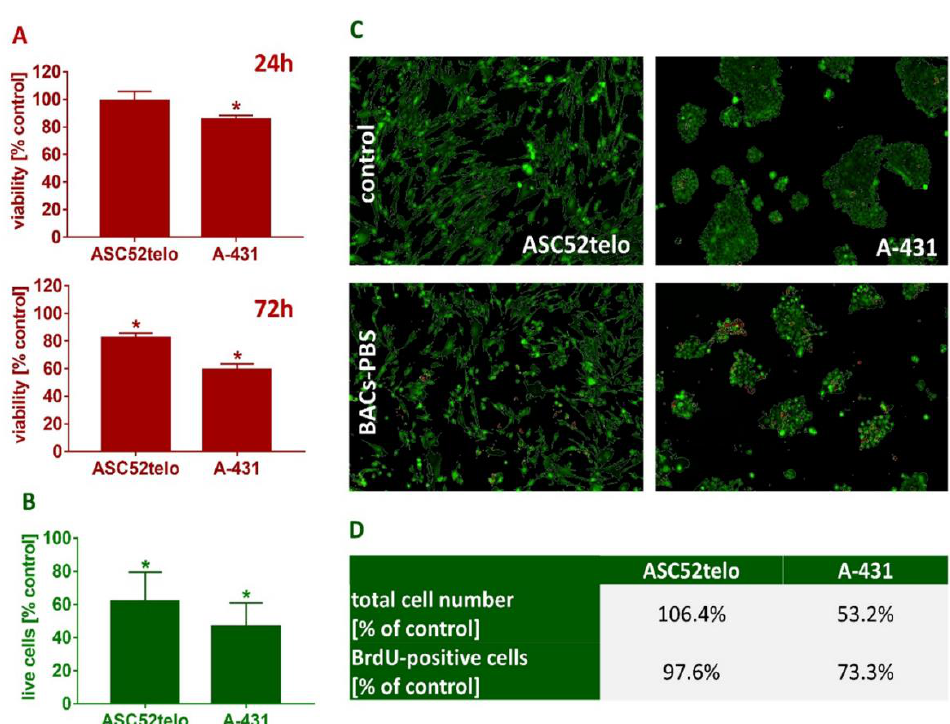
Figure 5. BACs extract influences on proliferation and viability of cultured cells. ( A ) ASCs and A-431 viability after incubation with BACs extract. ( B ) Esterase activity in cells cultured with the extract. Bars represent standard deviation; * Denotes significant difference at p < 0.05. ( C ) Representative images of ASCs and A-431 cells cultured for 72 h in 20-fold diluted BACs extract. As analyzed by dedicated software, green stands for live cells and red for dead cells. ( D ) Proliferation of ASCs and A-431 cells cultured with the